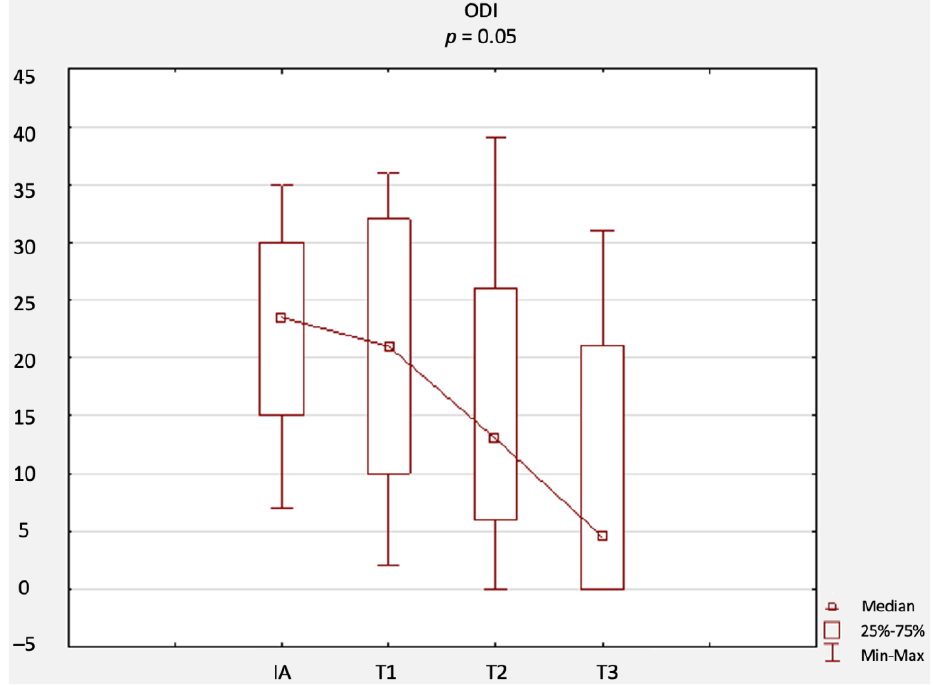
Figure 3. Comparison of ODI questionnaire results at IA, T1, T2, and T3. Abbreviations: ODI, Oswestry disability index; IA, initial assessment; T1, first-month assessment; T2, second-month assessment; T3, third-month assessment.